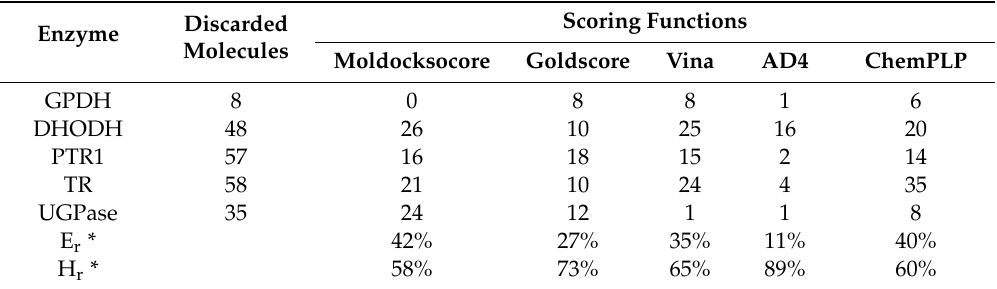
Table 10. Error rate and hit rate, calculated for each docking program, by target. Scoring Functions Enzyme Discarded Molecules Moldocksocore Goldscore Vina AD4 ChemPLP GPDH 8 0 8 8 1 6 DHODH 48 26 10 25 16 20 PTR1 57 16 18 15 2 14 TR 58 21 10 24 4 35 UGPase 35 24 12 1 1 8 E r * 42% 27% 35% 11% 40% H r * 58% 73% 65% 89% 60%